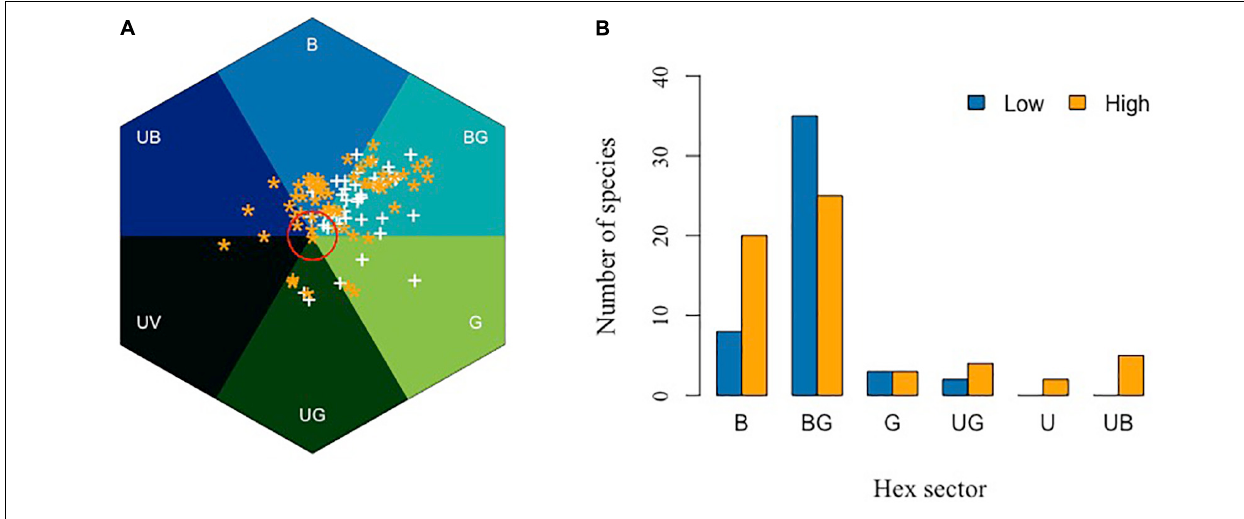
FIGURE 9 | In search of blue in different elevation. (A) Bee color space for low (900–2000 m, white symbol “+”) and high (2700–4100 m, orange asterisk “*”) altitude of Nepal. Red circle is 0.11 hexagon unit which shows the achromatic region where bees are predicted to be poor at detecting colors against a foliage background. (B) Number of Himalayan plant species classified in the various hexagon categories of bee color space. Flower colors are not equally distributed across color sectors (Chi-square = 6.77, df = 1, P = 0.009), with a higher number of blue flowers being observed at higher altitudes ( z = 2.76, p < 0.05). Data are available in Supplementary Appendix 3